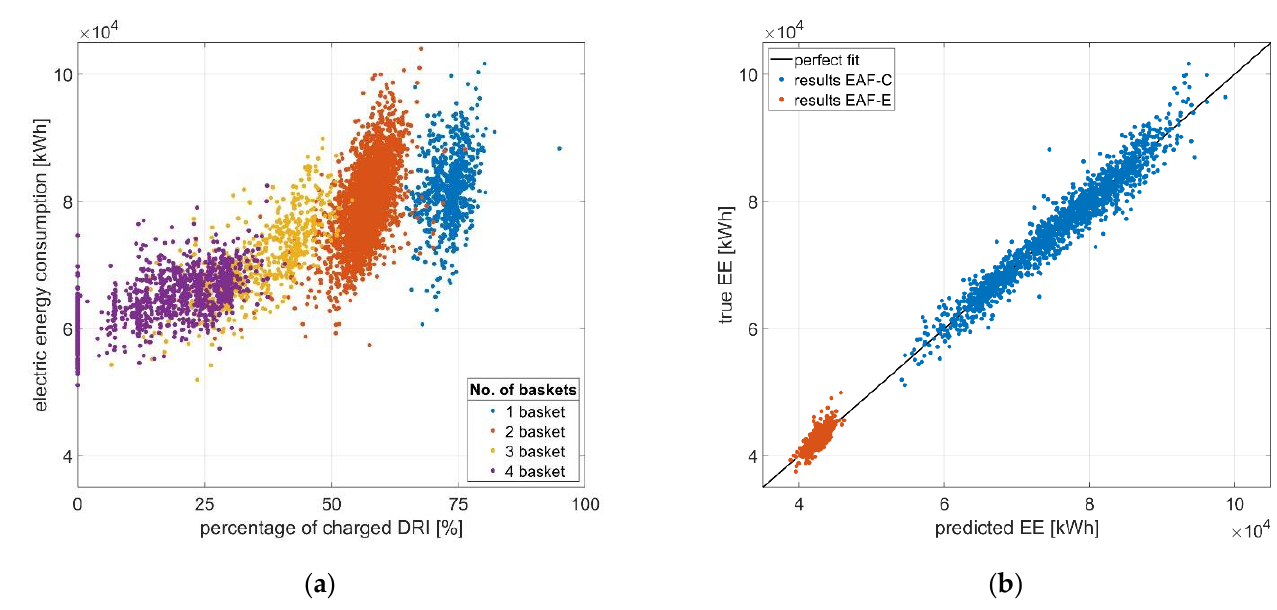
Figure 3. ( a ) Percentage of DRI charged in EAF-C with varying number of baskets; ( b ) Comparison of the estimated electric energy demand for EAF-C and EAF-E.